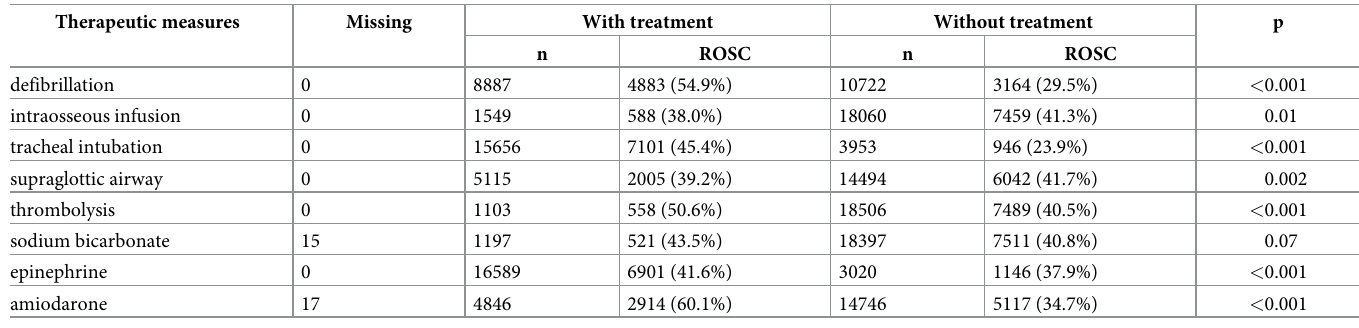
Table 2. Valid cases concerning therapeutic measures.